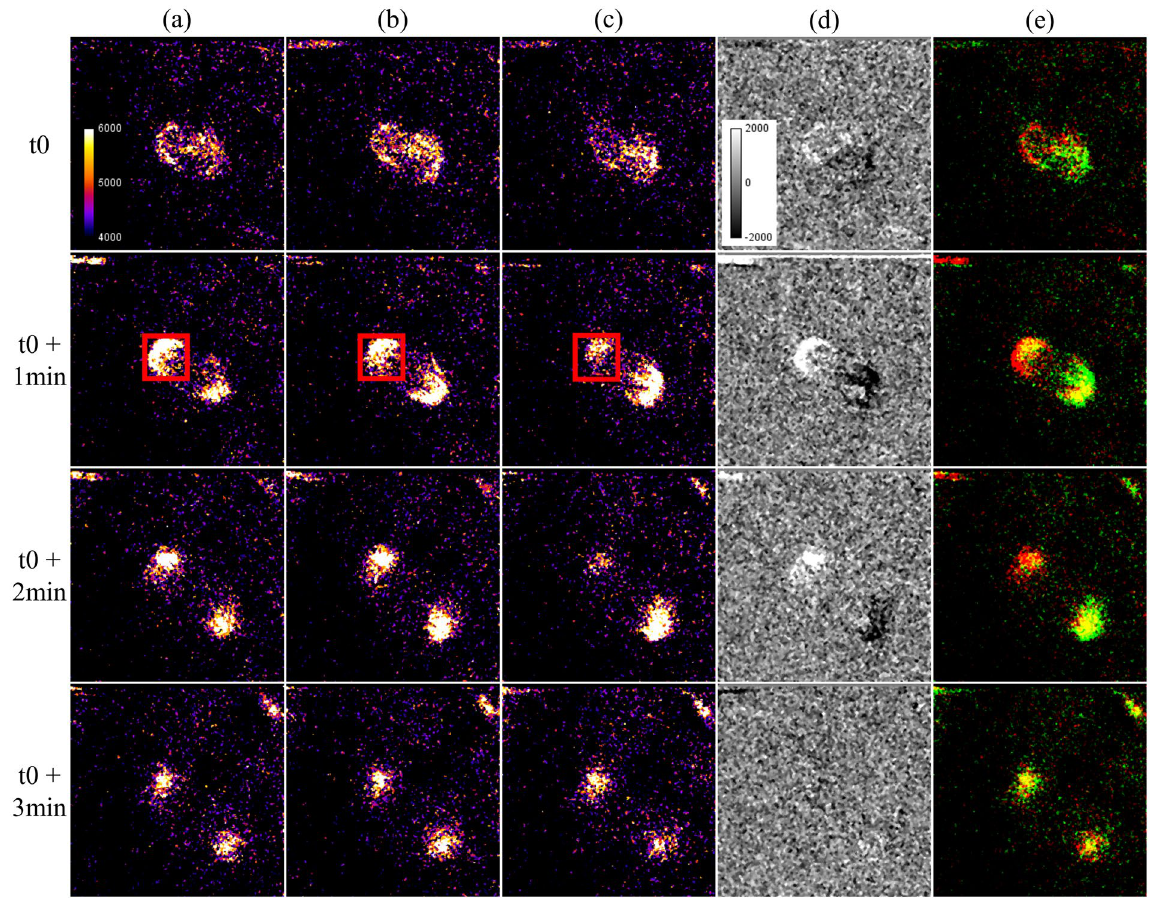
Figure 2. I-SHG of mitotic spindles in a zebrafish embryo. ( a – c ) Images acquired with different reference phases (0°, 90° and 180° respectively). Constructive and destructive interference occurs in opposite poles at 0° and 180° while no variations are observable at 90°. ( d ) Subtraction of the images ( a , c ) showing the interferometric contrast in the two poles. ( e ) 2-colors merge of the images acquired at 0° (in red) and 180° (in green). Average power at focus: 100 mW, photomultiplier tube set at 1050 V. Field of view: 50 × 50 µ m 2